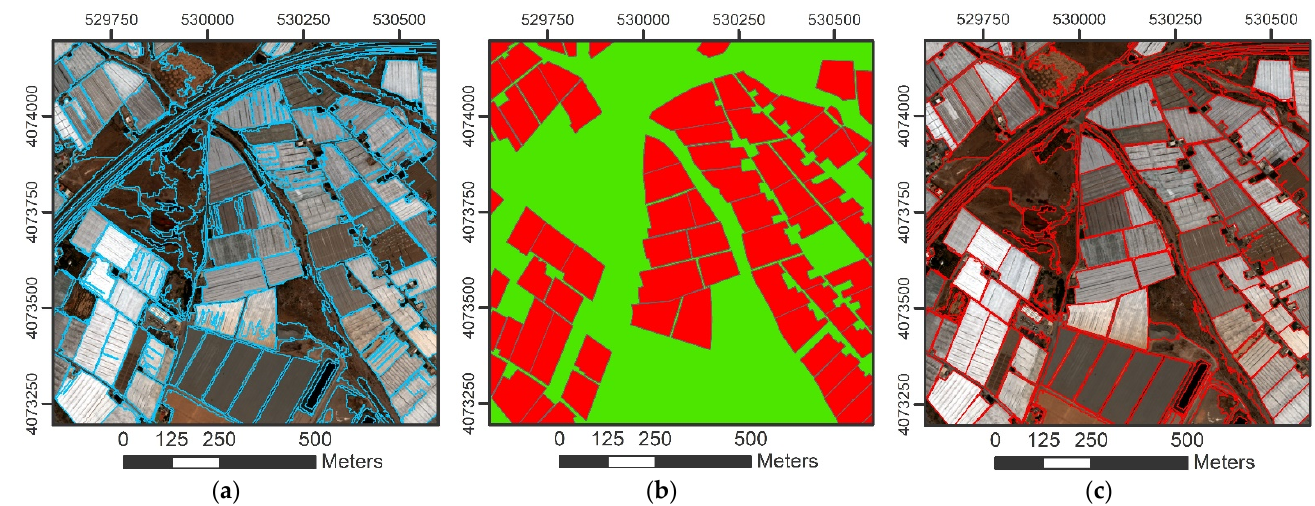
Figure 3. Segmentation stage on a detailed area: ( a ) Ideal MRS segmentation achieved using the modified Euclidean Distance 2 (ED2); ( b ) manual digitized ground truth; ( c ) final segmentation including GH ground truth geometry.